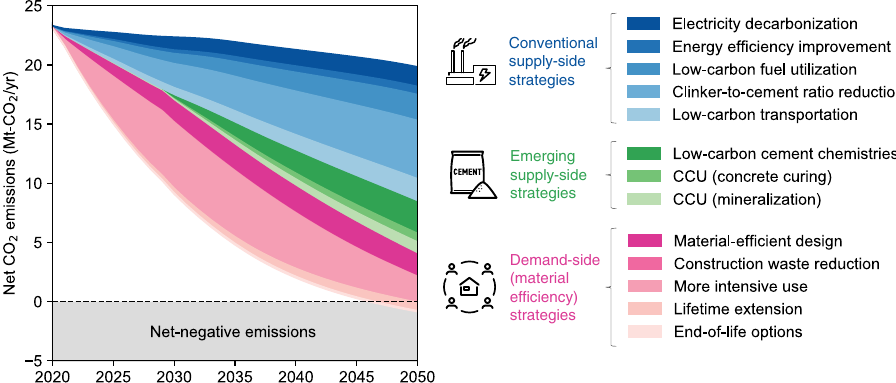
Fig. 3 Role of supply- and demand-side strategies in net CO 2 emissions associated with the cement and concrete cycle in Japan, 2020 – 2050. Conventional supply-side strategies are envisioned to enhance the current cement and concrete industry ’ s efforts to reduce CO 2 emissions, while emerging supply-side strategies refer to strategies that are innovative, but could take some time to scale up. Demand-side strategies refer to interventions by systems and actors that use concrete in the built environment. CCU carbon capture and